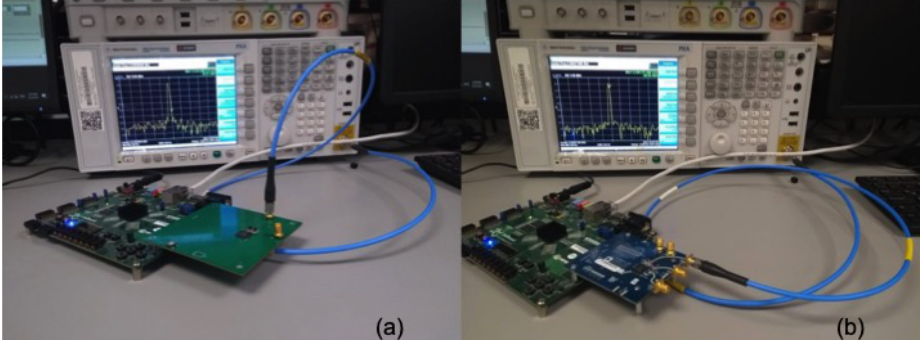
Figure 9. Implementation of the test bed for the RABE prototype. ( a ) tests of the manufactured prototype . ( b ) tests of the FMCOMMS4 card.